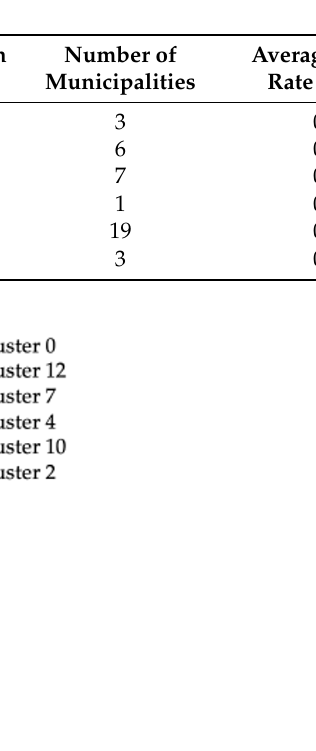
Figure 4. Distribution of municipalities in extreme clusters.